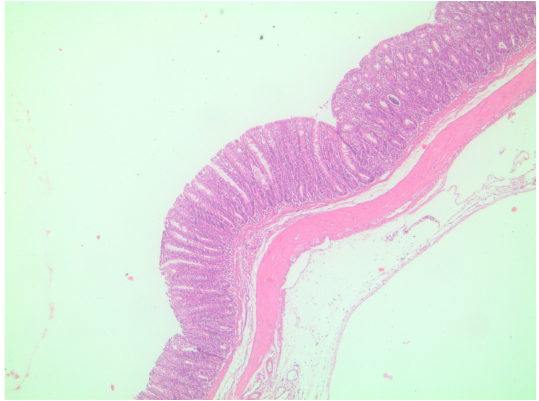
Figure 1. Acetic acid group on day 3, neutrophil-rich inflammatory cells in the lamina propria (H&E, × 40). H&E, hematoxylin and eosin.